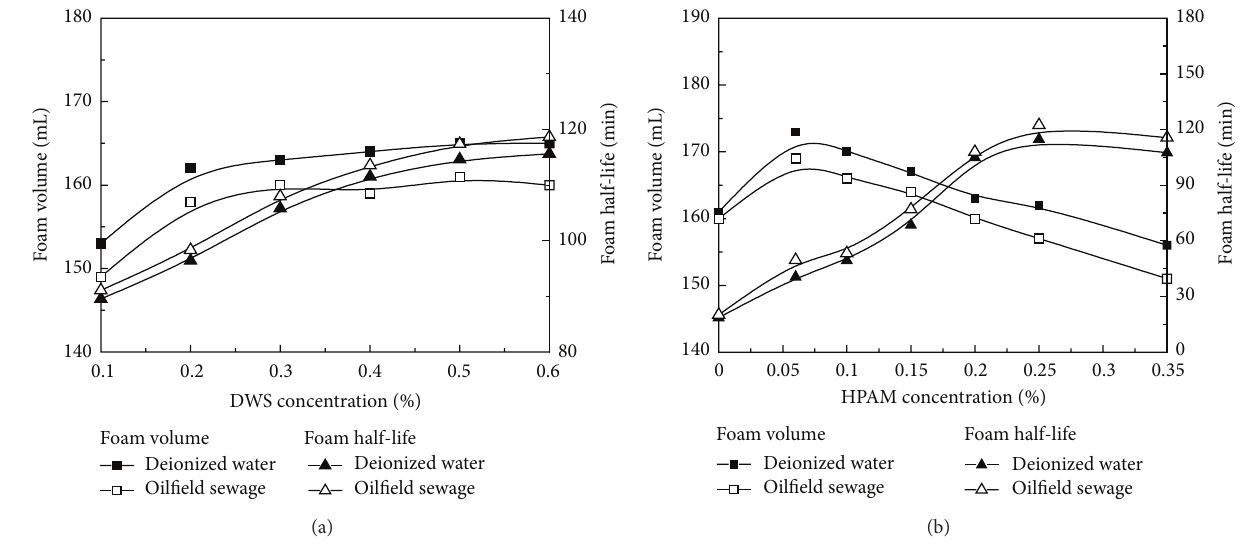
Figure 4: Foam volumes and stability of DWS in HPAM systems.